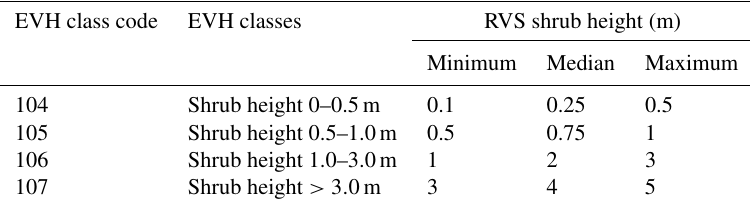
Table C1. Thematic classes representing shrub heights in the LANDFIRE EVH product and the associated height values represented in the RVS fuel modeling system.